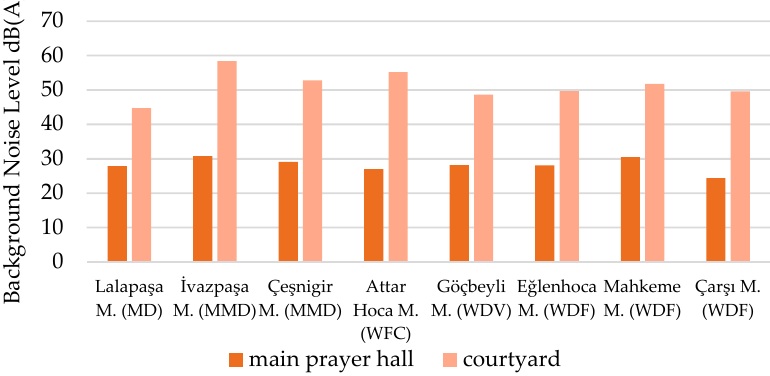
Figure 17. The background noise levels from indoor and courtyard of mosques.